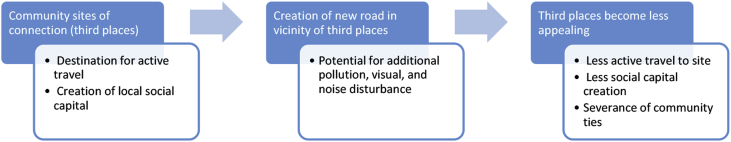
Creation of Severance through impact on third places.